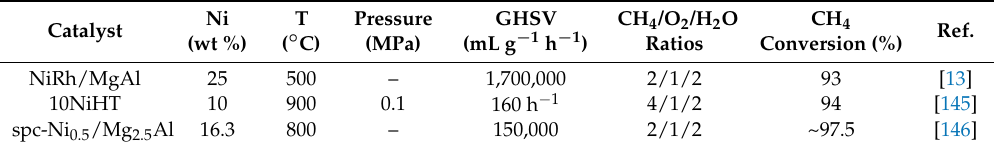
Table 6. Catalytic performance of autothermal reforming for different catalysts in different